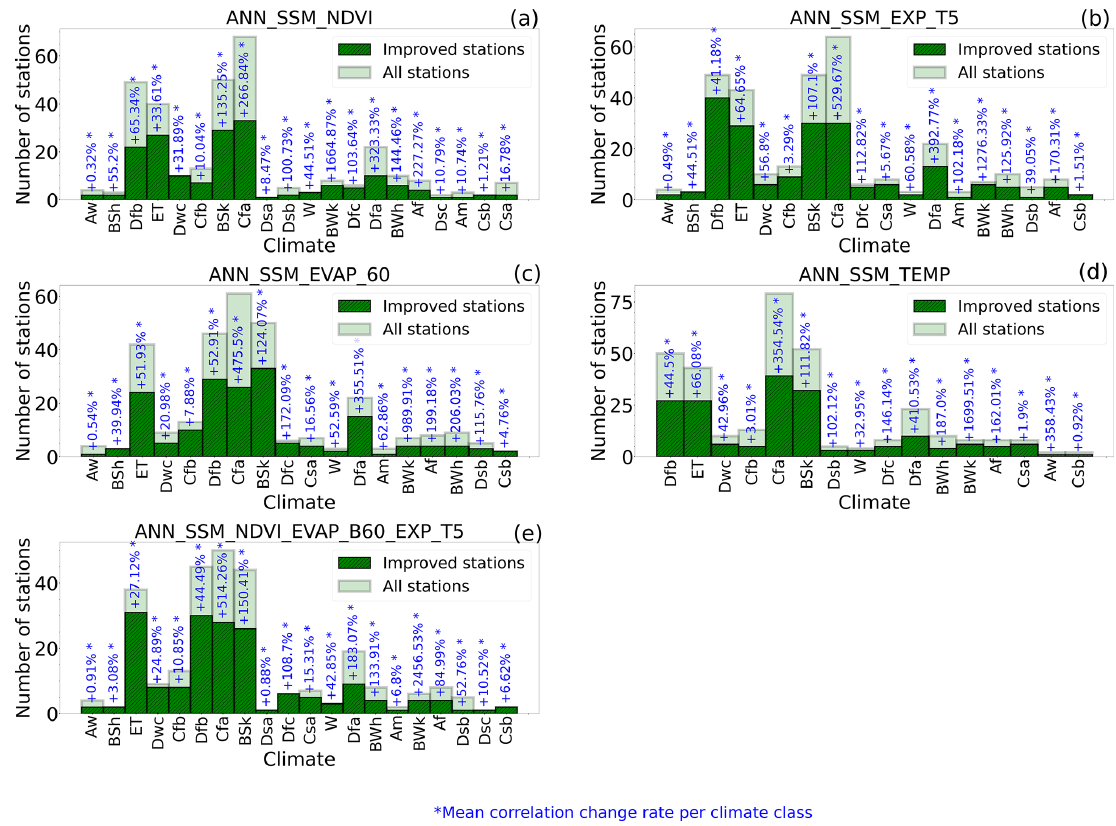
Figure 5. Climate classification of the stations performing better with models (a) ANN_SSM_NDVI, (b) ANN_SSM_EXP-FILT-T5, (c) ANN_SSM_EVAP-EFF-B60, (d) ANN_SSM_TEMP and (e) ANN_SSM_NDVI_EVAP-EFF-B60_EXP-FILT-T5 compared to model ANN_SSM (dark green corresponds to stations whose correlation improved with complexified models, light green corresponds to total stations and rate in blue corresponds to the mean correlation change rate per climate class). Table 6. Performance metrics of models ANN_SSM, ANN_SSM_NDVI and ANN_SSM_NDVI_EVAP-EFF-B60_EXP-FILT-T5 at the sites in southern India and northern